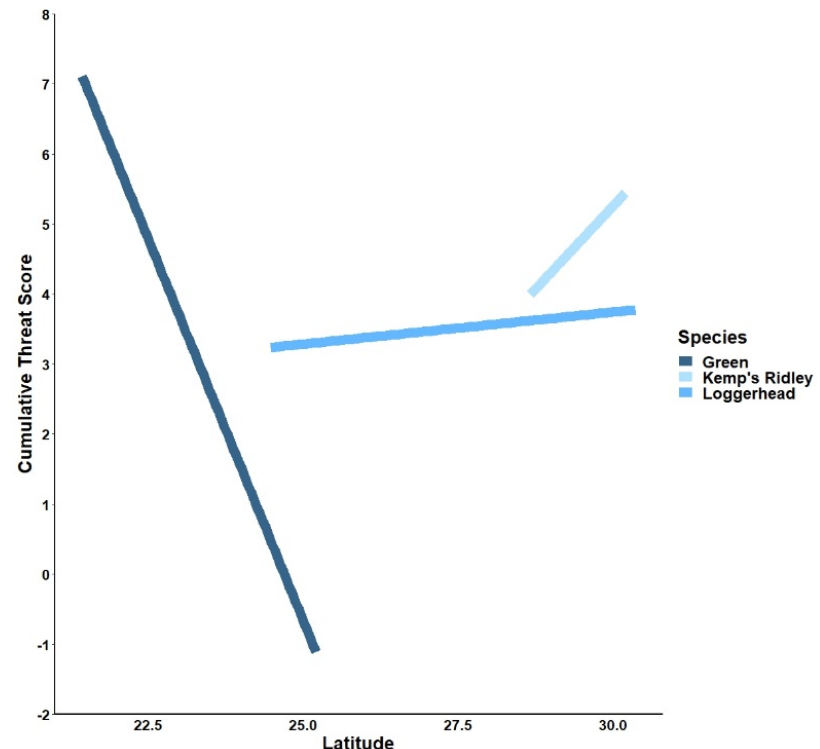
Figure 4. Interactive effects plot of Latitude × Species by the total score of all threats combined (cu- mulative impact score) using standardized scores. Standardizing threat scores reassigns values based on a mean of 0 and standard deviation of 1. Values are then re-calculated accordingly. PERMANOVA results detected a significant relationship between the interaction of species x latitude predicting threat (F 2,448 = 29.628, p = 0.001). Low threat scores for green and loggerhead turtles coincide with the presence of the Florida Keys National Marine Sanctuary and Dry Tortugas National Park. Kemp’s ridleys display lower threat scores in southern latitudes.